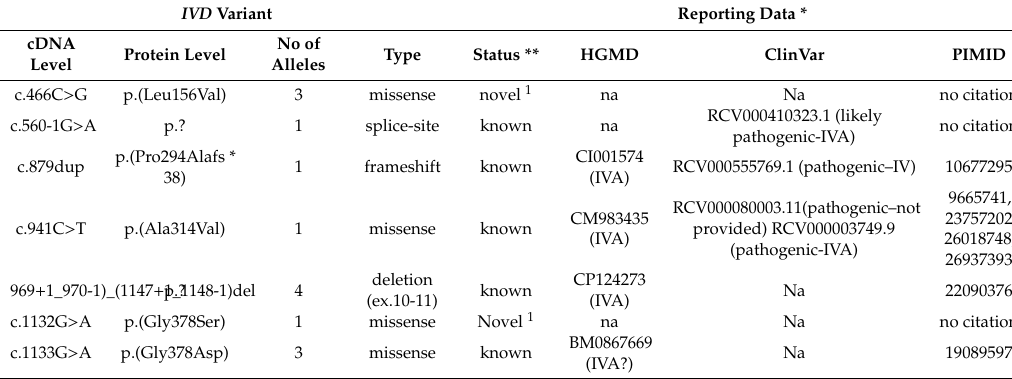
Table 2. Additional data on molecular variants identified in IVD gene.